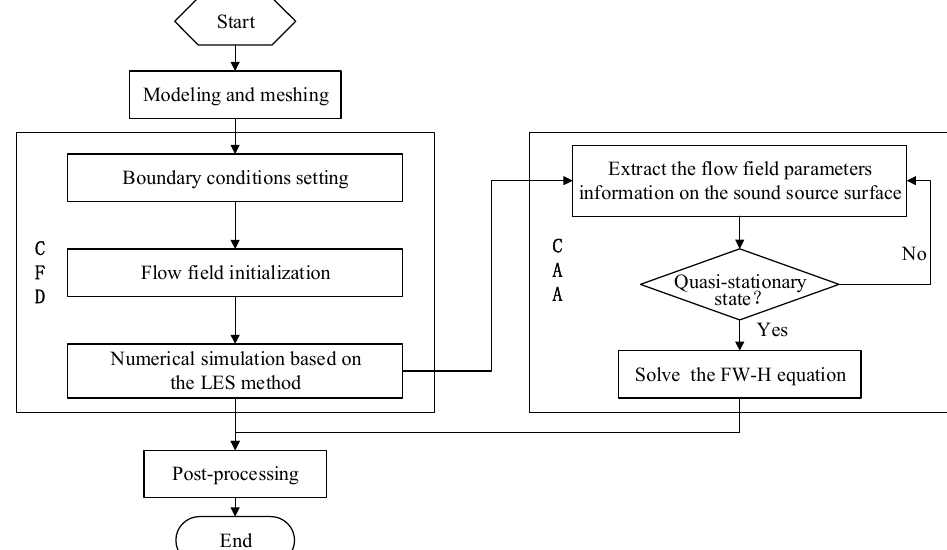
Figure 5. Flow chart of the CFD-CAA hybrid method.